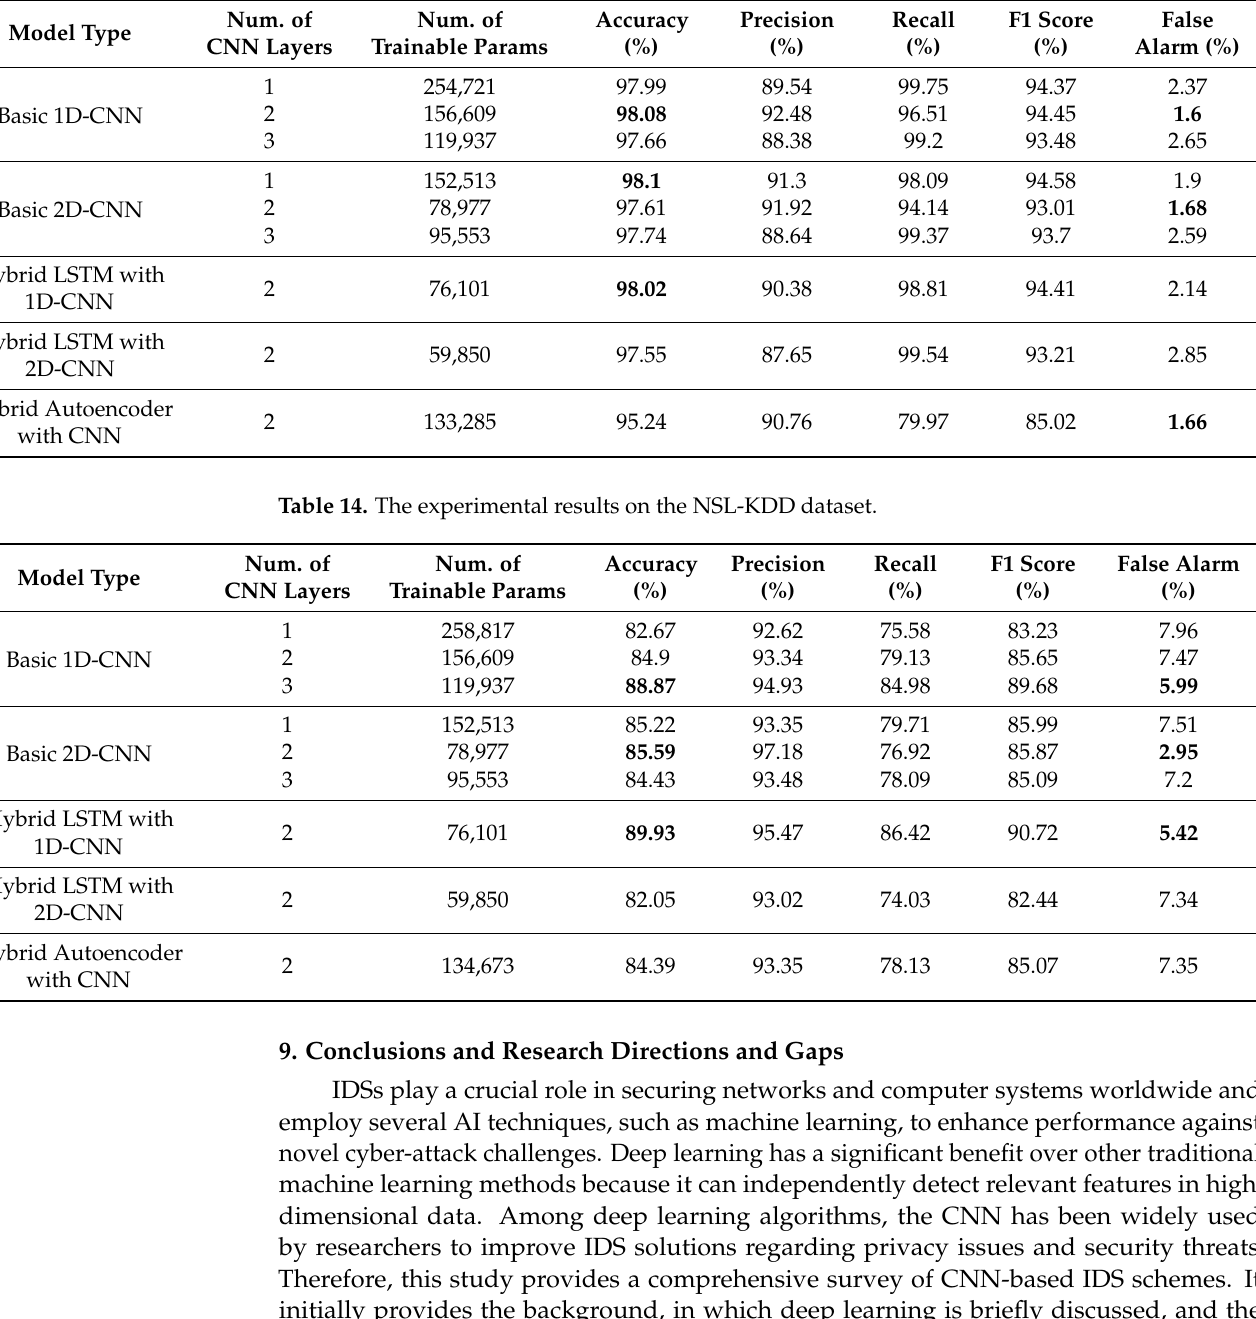
Table 13. The experimental results on the CIC-IDS 2017 dataset.